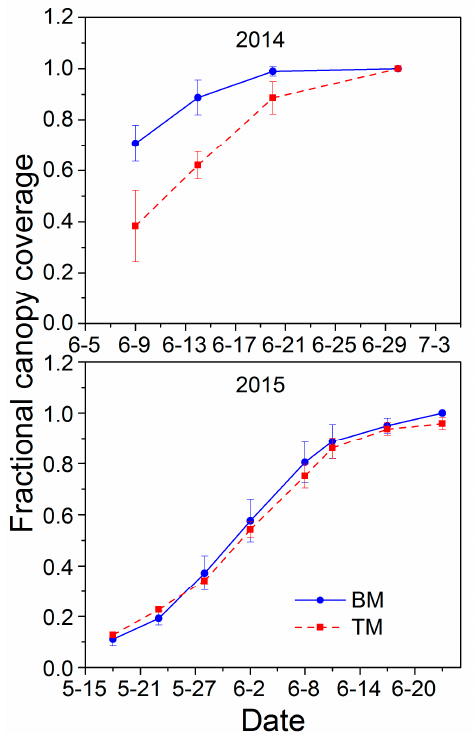
Figure 5. Fractional canopy coverage by potato grown with transparent plastic film (TM) and black plastic film (BM) treatments at Wuwei, China, in 2014 and 2015.